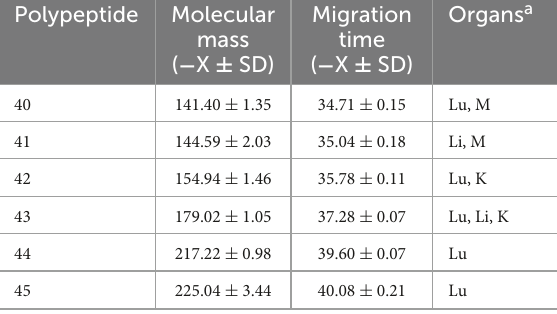
c Lirepresentsliver. d Krepresentskidney. e